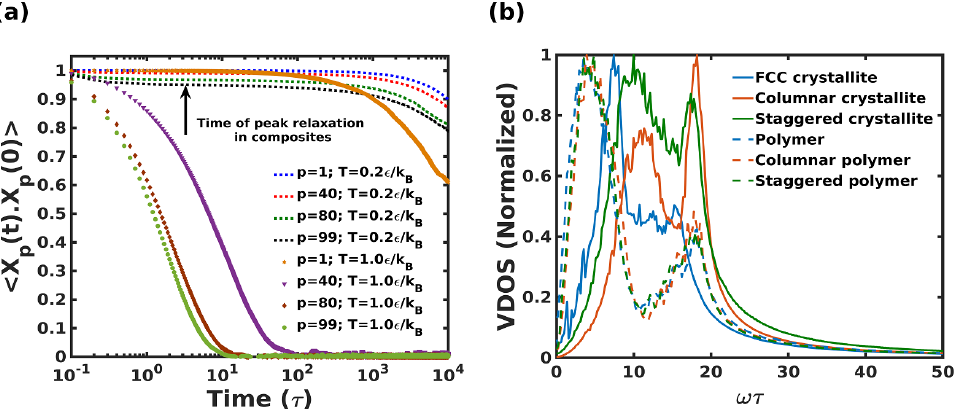
Figure 12. ( a ) Rouse mode numbers denoted ( p = 1,40,80 & 99) for homopolymer system of chain length N = 100 at melt ( T = 1.0 (cid:101) / k B ) and glassy state ( T = 0.2 (cid:101) / k B ) . The autocorrelation function is normalized to scale the characteristic time scale, ( b ) VDOS of the composite systems added to partial VDOS of components arising from the crystalline and polymeric